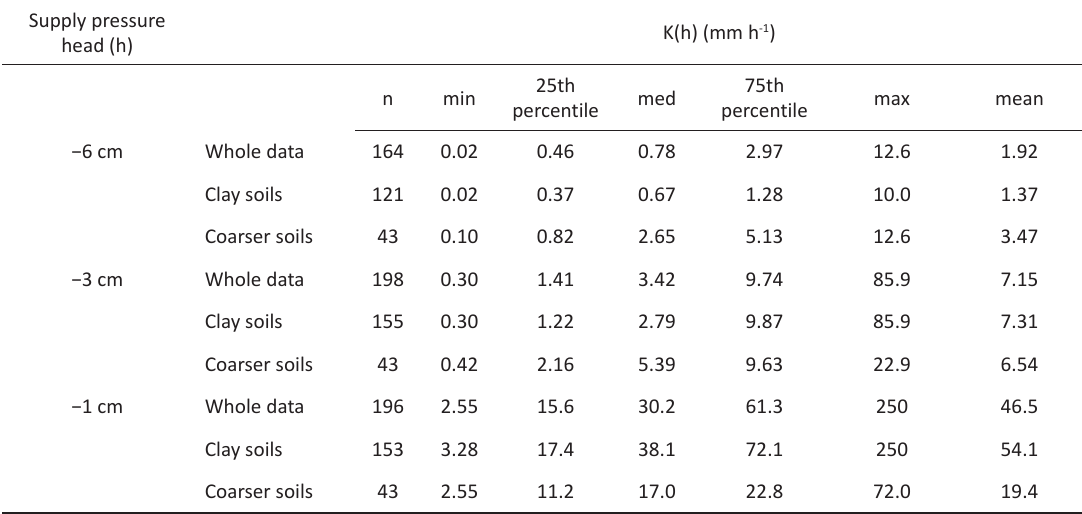
Table 1. Distribution of near-saturated hydraulic conductivity (K( h )) values measured in 20 field plots at the Jokioinen and Maaninka research stations, 2016−2018 Supply pressure head